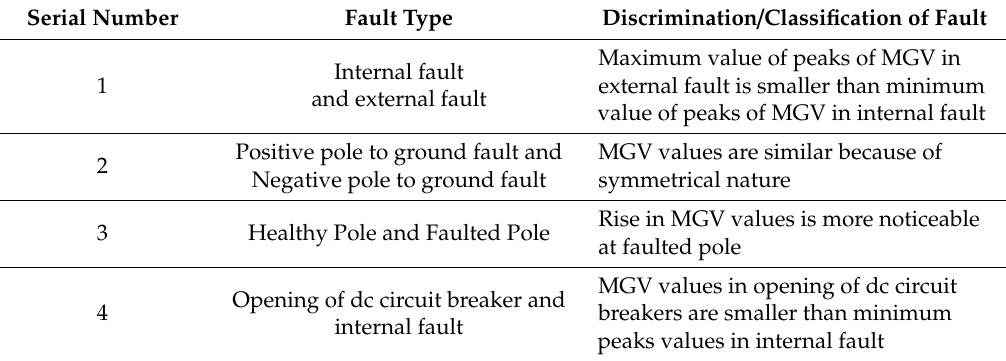
Table 1. Cases of rise of dc fault current in terms of morphological gradient voltage (MGV) values.